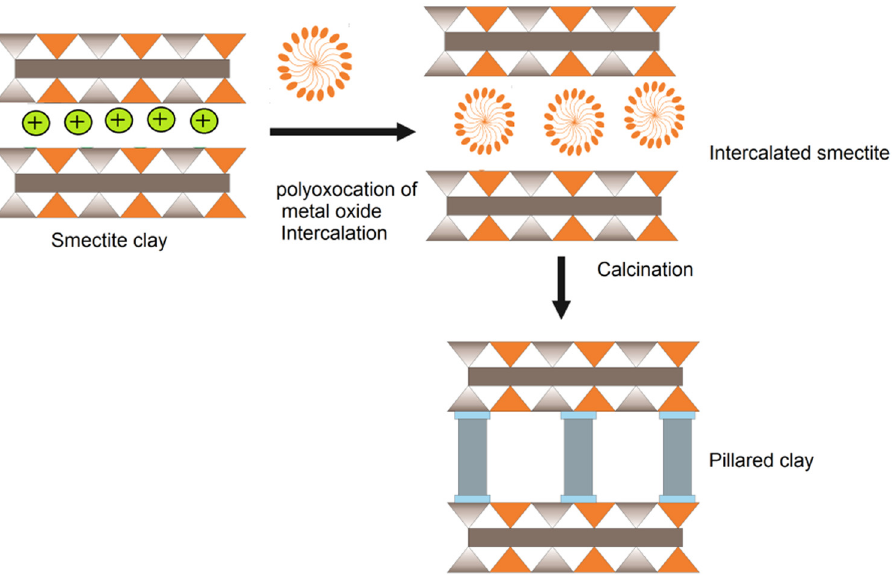
Figure 3: Schematic representation of clay